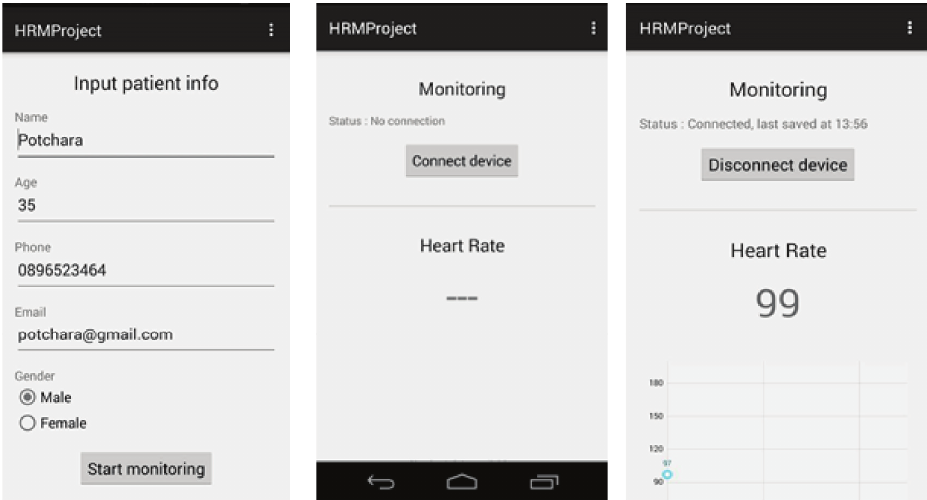
Figure 3: Application interface of listening port: patient basic information, connection notification, and real-time